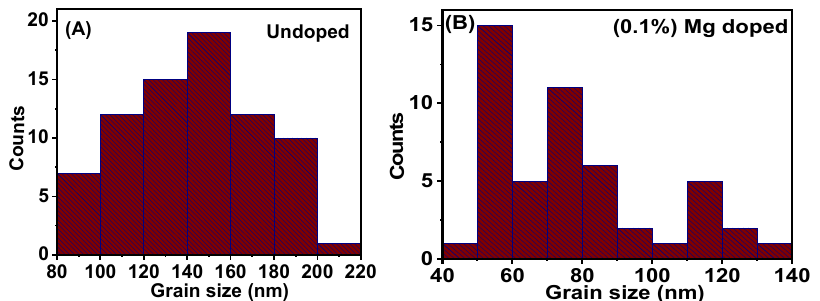
Figure 3. Grain size distribution plots for ( A ) undoped lithium aluminium borate and ( B ) 0.1% magnesium-doped lithium aluminium borate.